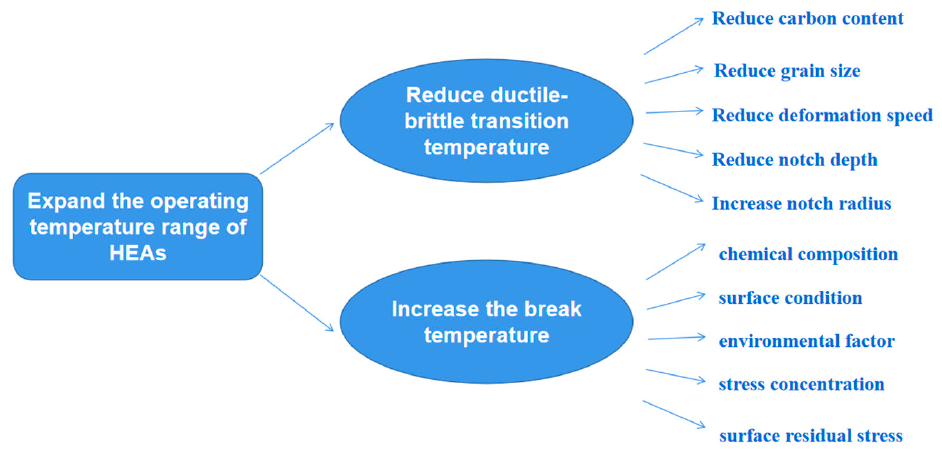
Figure 9. Ways to expand the operating temperature range of HEAs.